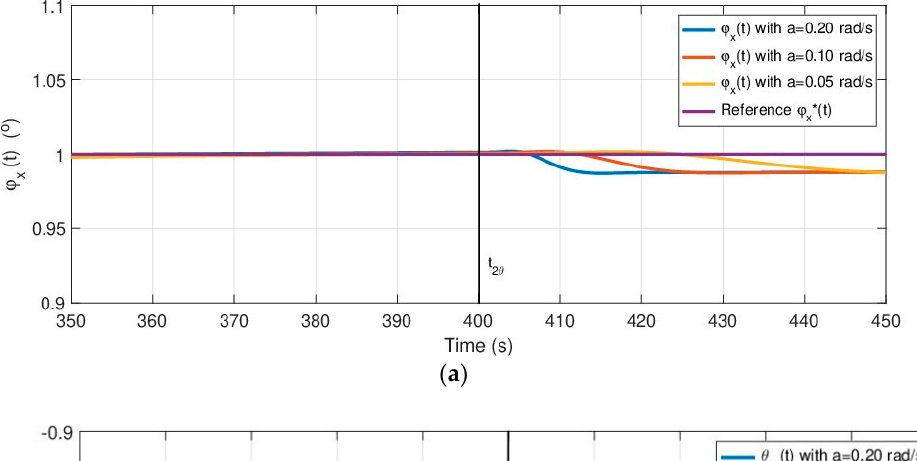
Figure 14. Design criteria for parameter 𝑎 .